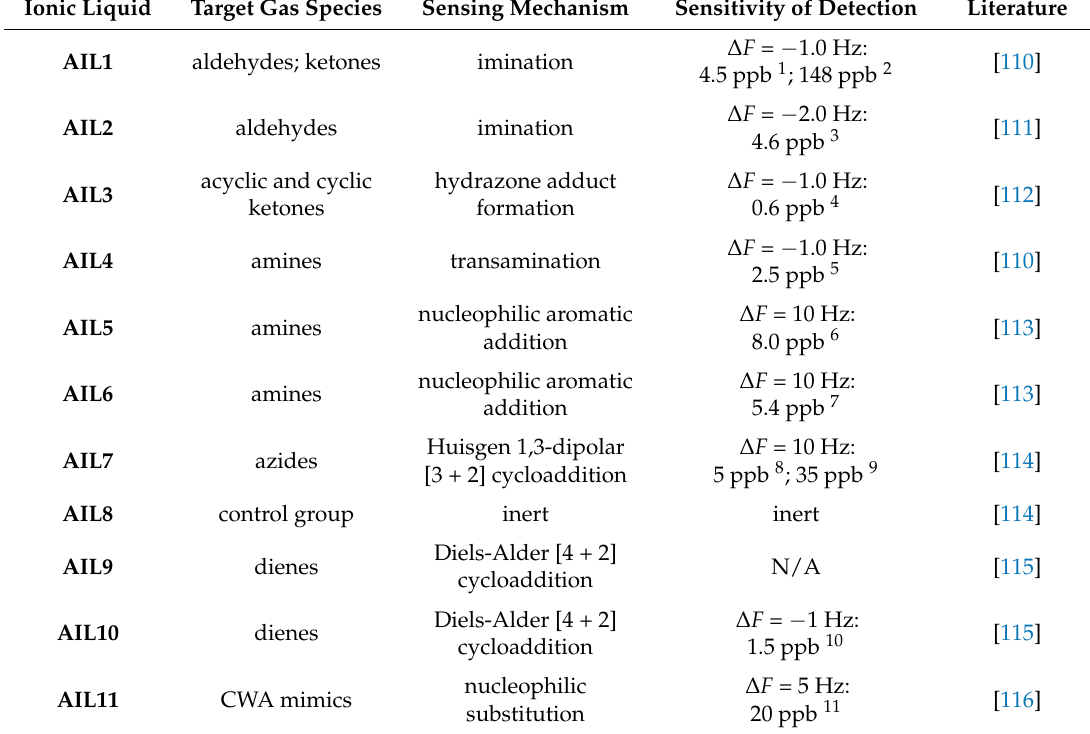
Table 1. A brief description of the working principles AILs employed, the targeted analytes and the sensitivity of